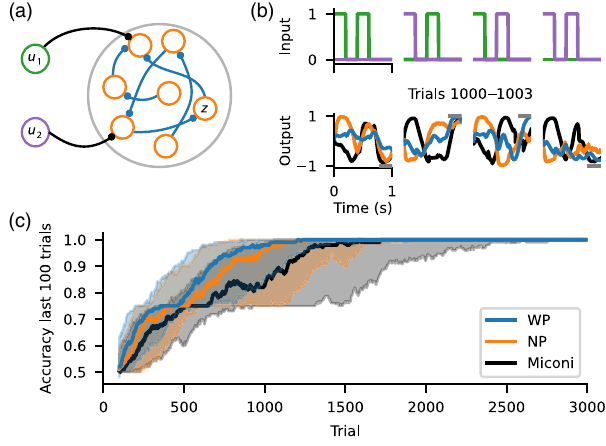
FIG. 8. WP performs as well as NP on a DNMS task. (a) Schematic of the recurrent network with inputs u 1 and u 2 and output z . All network weights are learned; i.e., for WP, all network weights (blue) are perturbed, and for NP, all network nodes (orange) are perturbed. (b) Inputs and outputs during example trials. Top row: inputs u 1 (green) and u 2 (purple) for the four different trial types. Bottom row: outputs for WP (blue), NP (orange), and the version of NP proposed by Ref. [14] (black) for trials 1000 – 1003 for the inputs shown above. Gray bars show target outputs. (c) Accuracy during training. WP (blue) performs similarly well as NP (orange) and the version of NP used by Ref. [14] (black). There is a noticeable transient slowdown at an accuracy of 75%, which corresponds to the successful learning of three out of the four different trial types. Solid lines show the median, and shaded areas represent the interquartile range between the first and third quartile using 100 network